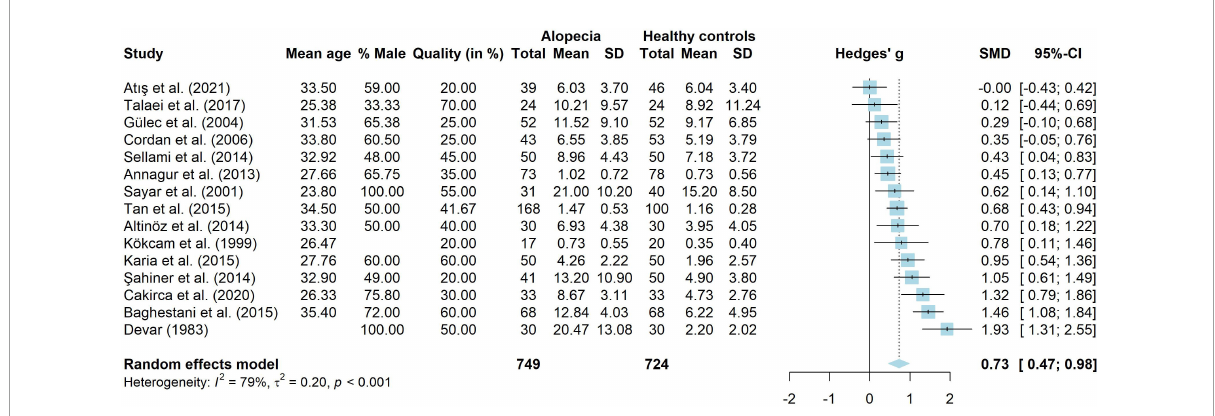
FIGURE3 Forest plot for symptoms of depression in adults with alopecia compared to healthy